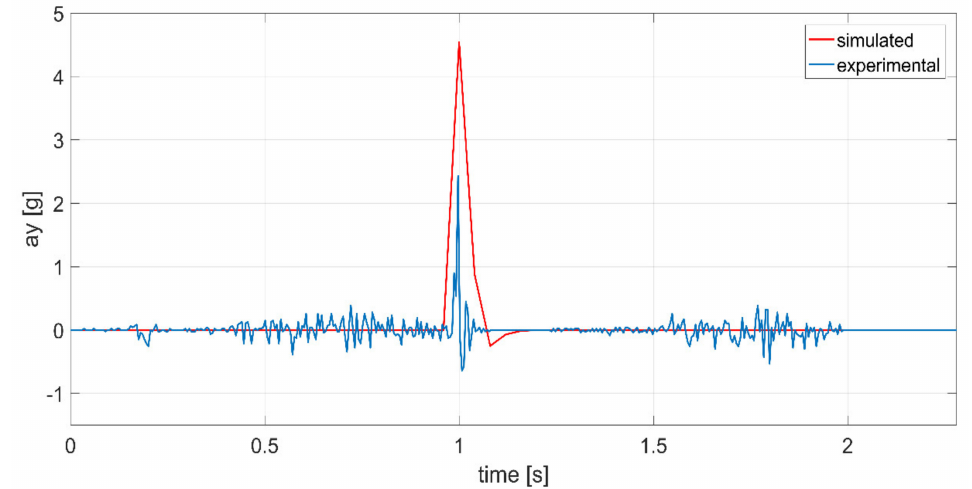
Figure 17. Comparison of the simulated and experimentally measured acceleration along Y-axis versus time during a grasping test.